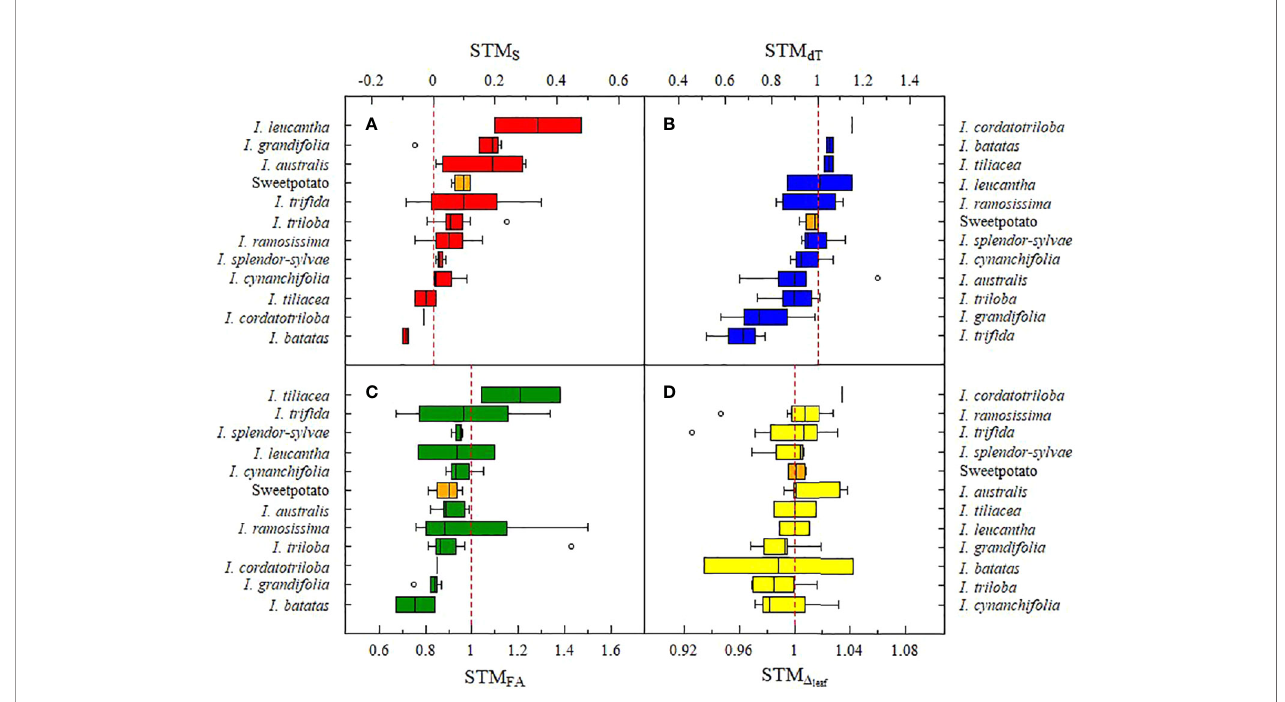
FIGURE 3 | Boxplot of short-term memory (STM) values per crop wild relatives (CWR) species and sweetpotato cultivars (orange boxplots) for senescence (STM S ) (A) , foliar area (STM FA ) (B) , leaf-minus-air temperature (STM dT ) (C) and leaf 13 C discrimination (STM D ) (D) . Red dashed line indicates the STM occurrence. In each specie ’ s boxplot, black line represents the median value. Boxplot contains the variation between 25 and 75% and gray circles are the outlier values.